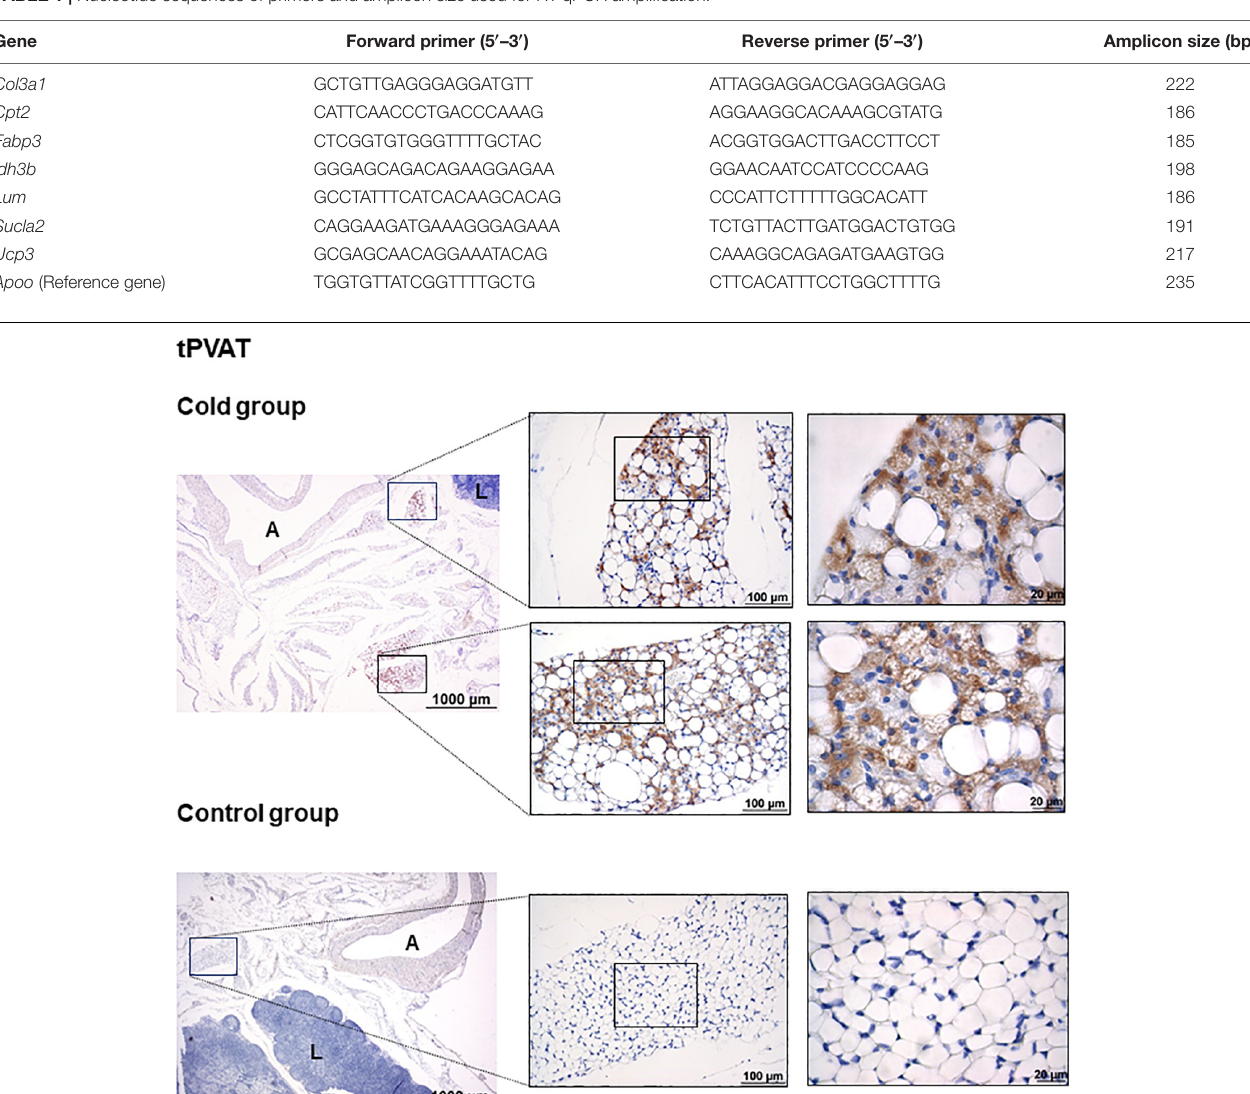
TABLE 1 | Nucleotide sequences of primers and amplicon size used for RT-qPCR amplification. Gene Forward primer (5 (cid:48) –3 (cid:48) ) Reverse primer (5 (cid:48) –3 (cid:48) )